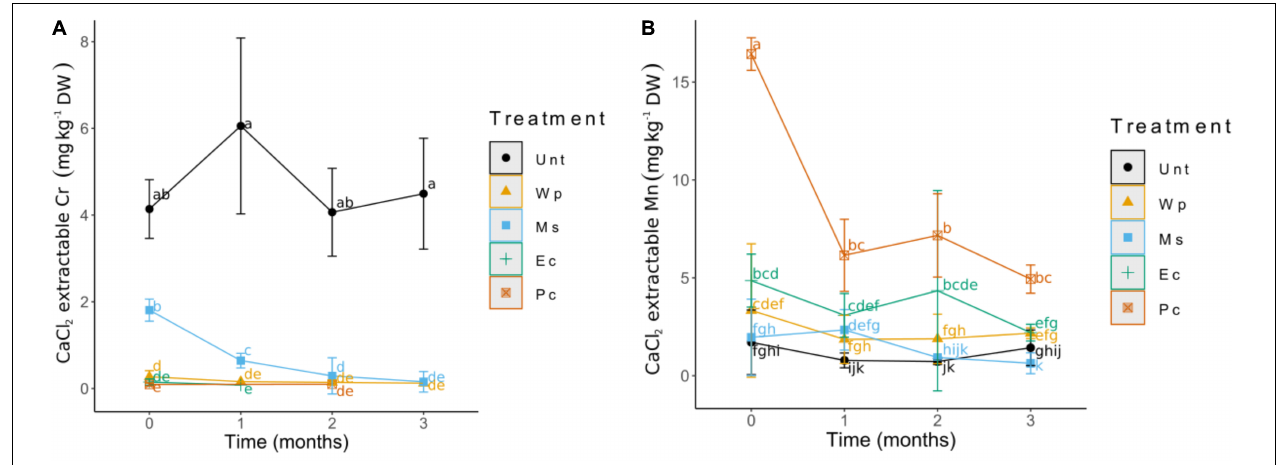
FIGURE 2 | Changes in the CaCl 2 extractable soil fractions of Cr (A) and Mn (B) . Values shown represent (means ± SD) the results of 12 replicates.